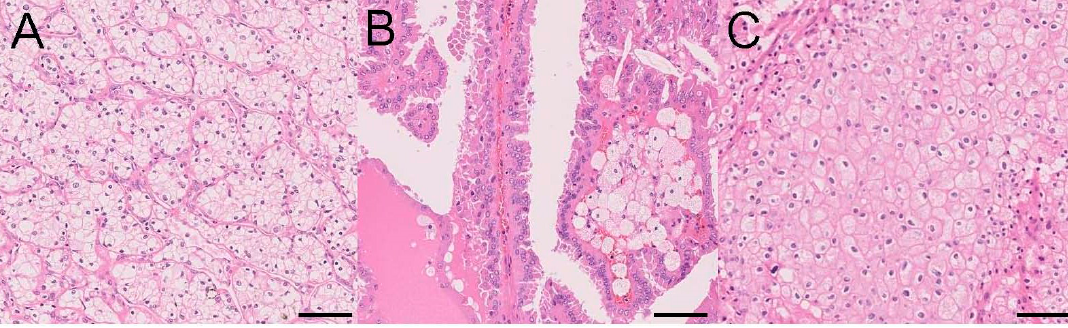
Figure 1. Morphology of the major subtypes of renal cell carcinoma (RCC) (hematoxylin and eosin staining; scale bar, 100 µm). ( A ) Clear cell RCC; ( B ) papillary RCC; and ( C ) chromophobe RCC. Clear cell RCC typically consists of clear cells with thin-walled, staghorn-shaped vasculature ( A ). Papillary RCC is typically composed of papillae formed by fibrovascular cores that often contain foamy macrophages ( B ). Chromophobe RCC typically contains a mixture of eosinophilic and clear cells with voluminous cytoplasm, perinuclear clearance, and well-defined cell borders, displaying a solid, sheet-like pattern ( C ).